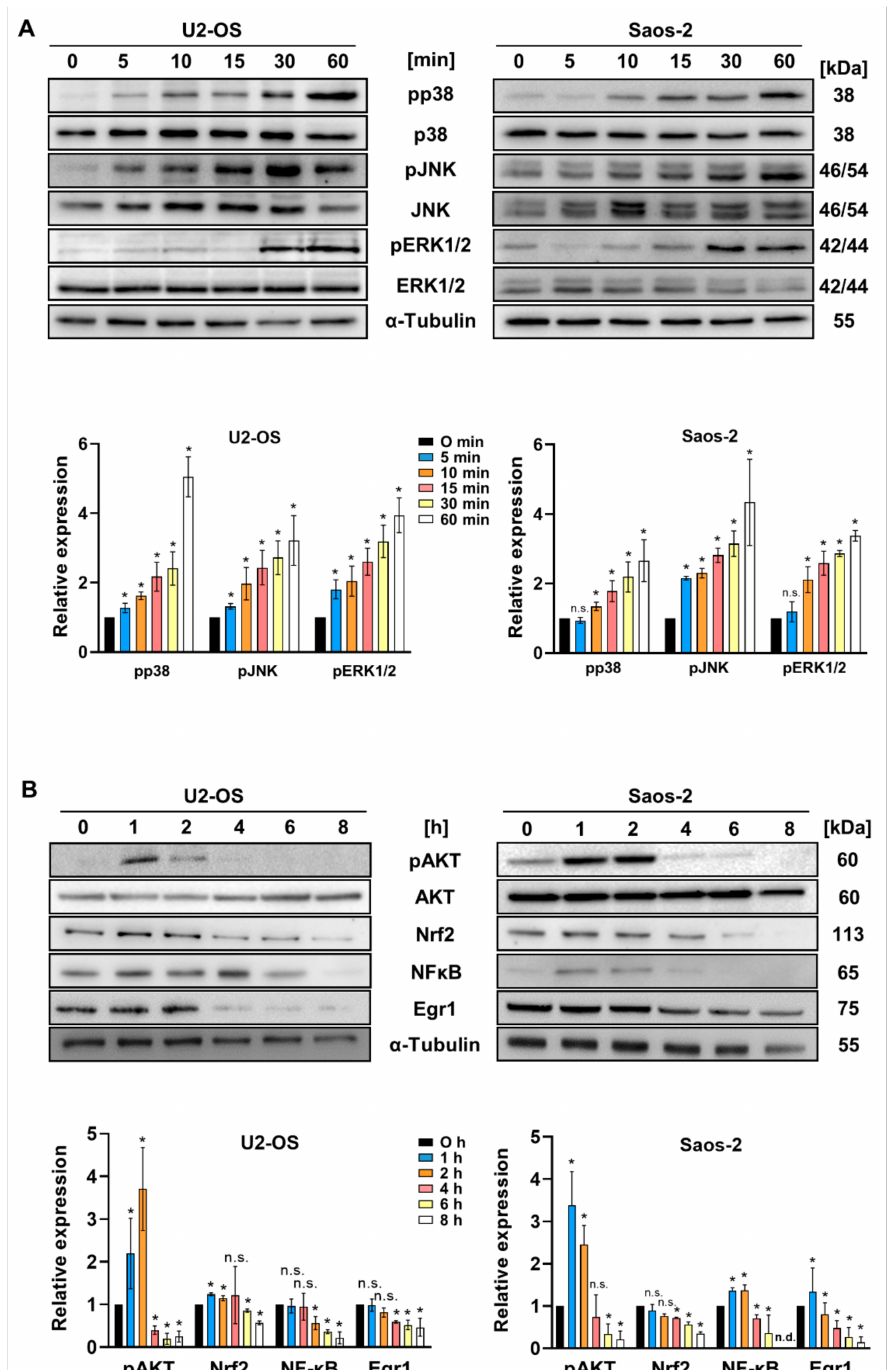
Figure 4. Activation of the MAPK pathway as an early downstream target of 15d-PGJ 2 . ( A ) U2-OS ( left panel) and Saos-2 OS cells ( right panel) were treated with 20 µ M 15d-PGJ 2 for indicated time periods and time-dependent MAPK phosphorylation status was analyzed by immunoblotting. One representative blot with corresponding densitometric evaluation based on at least three experiments are shown below. Alpha-tubulin ( α -tubulin) was used as a loading control. The data represented as means ± SD are compared to time point zero. (* p ≤ 0.05; n.s. = not significant) ( B ) In order to assess whether the further downstream effects of 15d-PGJ 2 include any cyto-protective mechanisms, immunoblots for antioxidant, pro-survival enzymes (AKT, Nrf2, NF- κ B, Egr1) were performed. One representative blot and densitometric evaluation of three independent experiments are shown (below). Alpha-tubulin ( α -tubulin) was used as a loading control. The data represented as means ± SD are compared to time point zero. (* p ≤ 0.05; n.s. = not significant); n.d. = not